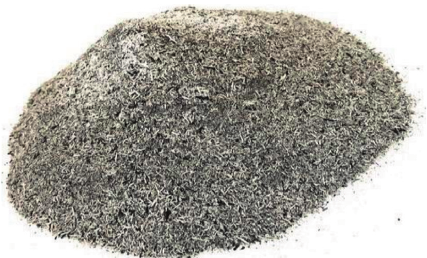
Figure 4: Rice husk